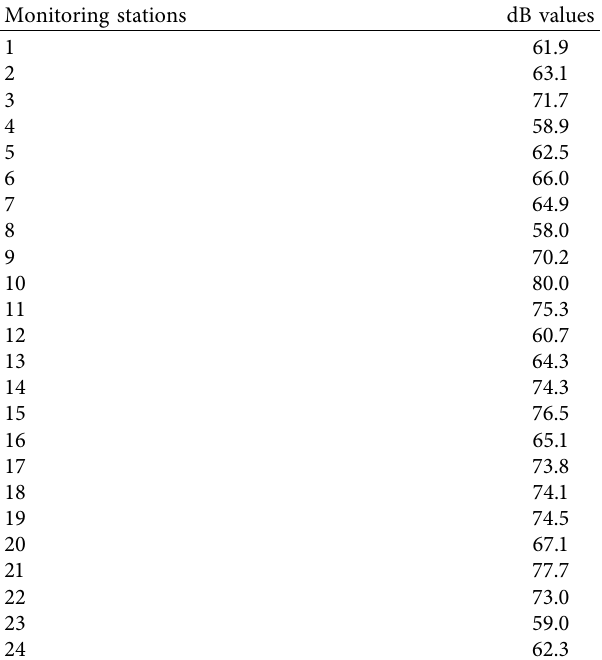
Table 2: Average decibel values at